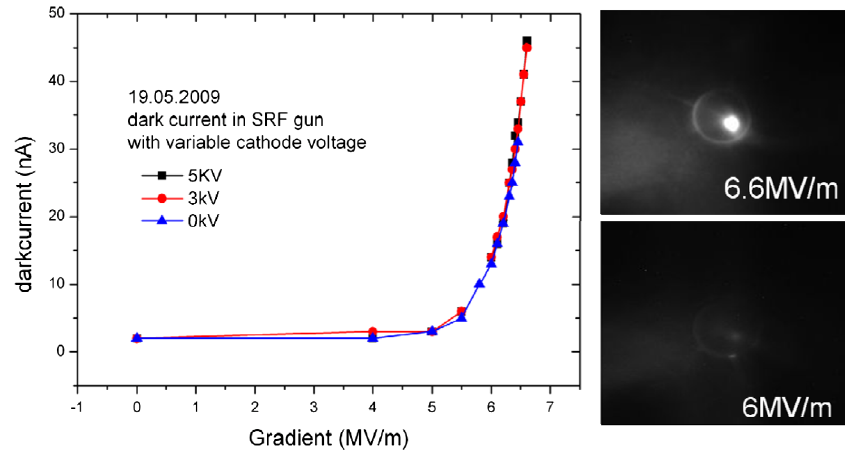
FIG. 8. (Color) Dark current measured in the SRF gun. The inserted photos are photocathode imagines obtained on the YAG screen (2.7 m from the photocathode) by using the dark current electrons and the solenoid.